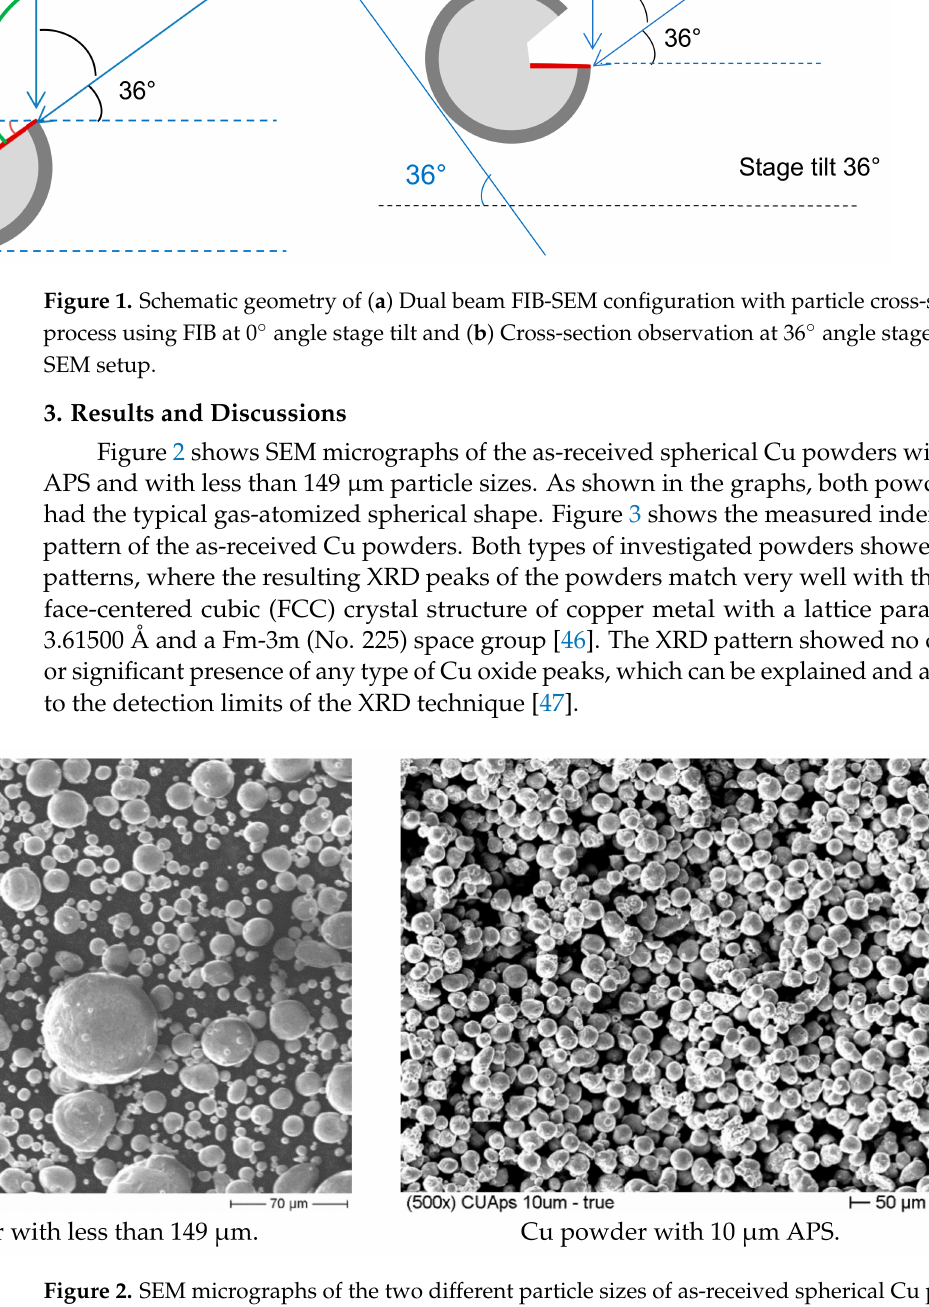
Figure 2. SEM micrographs of the two different particle sizes of as-received spherical Cu